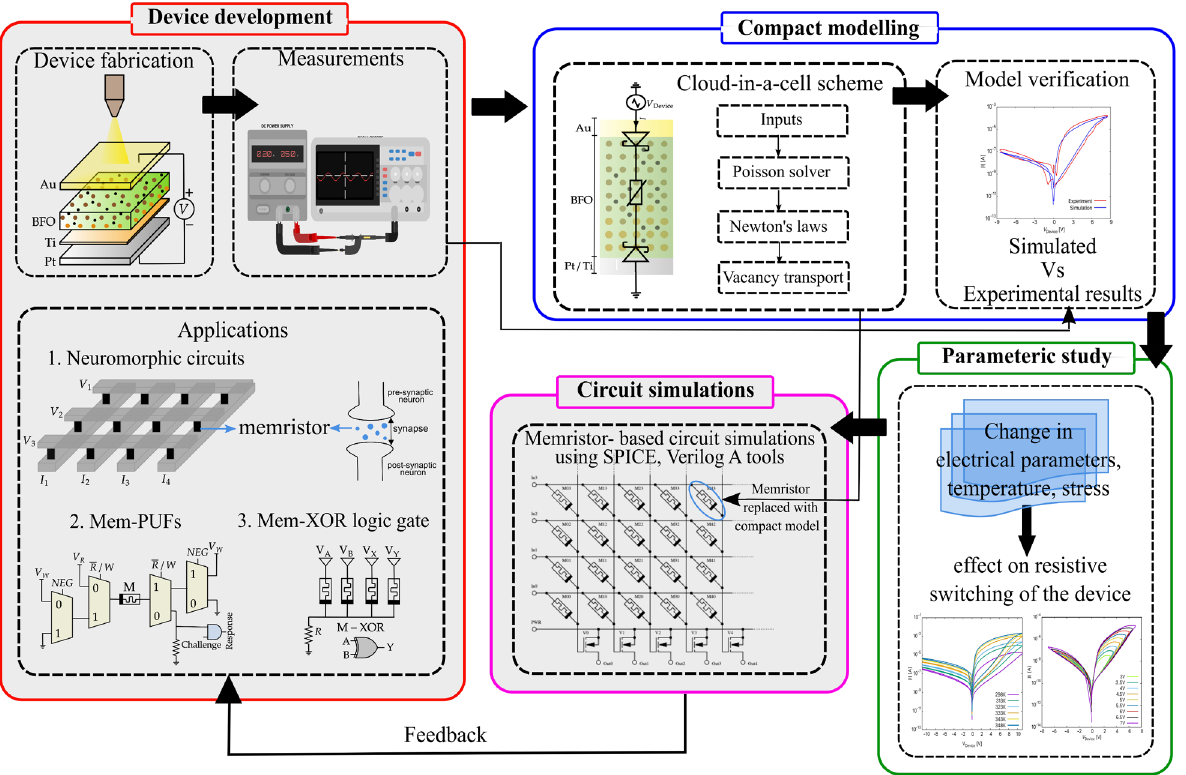
Figure 1. A flowchart illustrating the goal of the proposed work. The non-grey areas indicate the main steps addressed in the current